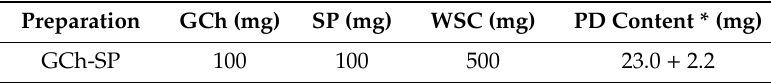
Table 1. Preparation condition and drug content of GCh-SP.